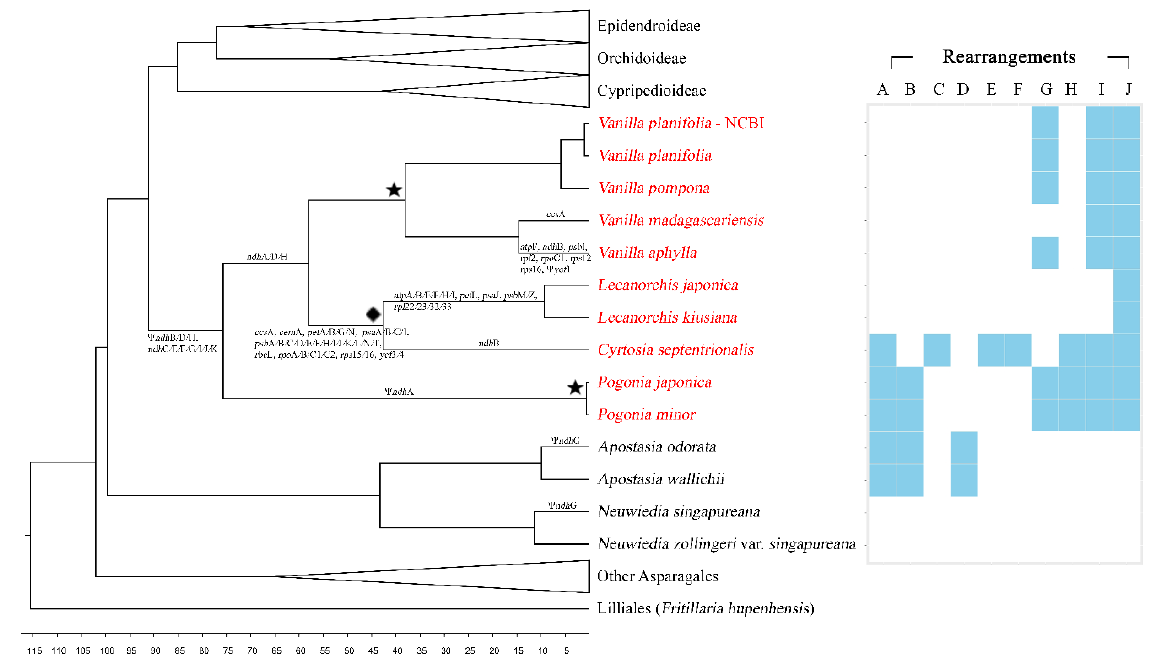
Figure 6. Summary of the rearrangements, mycoheterotrophy, SSC contraction, and gene reduction in the time estimation tree. A list of deleted or pseudogenized genes is above or beneath the tree nodes. A diamond mark in the phylogenetic tree indicates mycoheterotrophy of the clade. Star marks in the phylogenetic tree indicate the SSC contraction. Red scientific names indicate a Vanilloideae species.